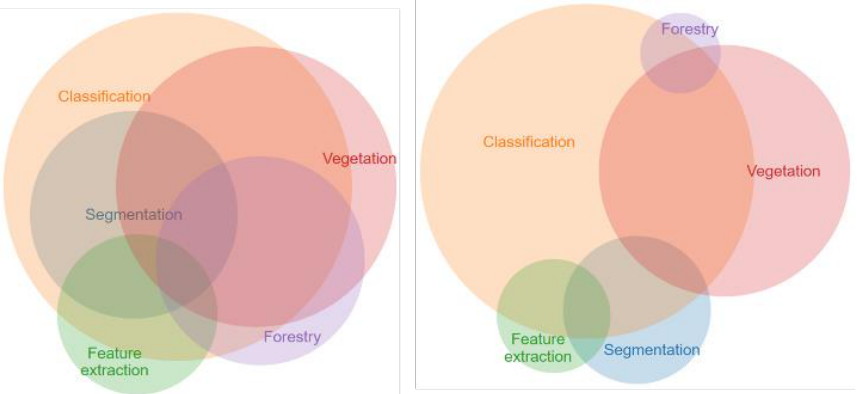
Figure 9 . Venn diagram (Scopus on the left, Web of Science on the right). Charts realized on